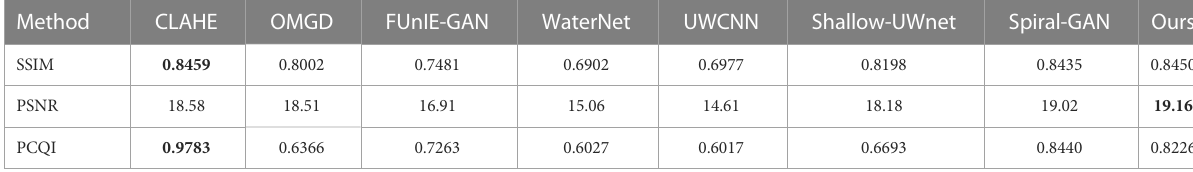
TABLE 1 Quantitative evaluation on the UIEB dataset.